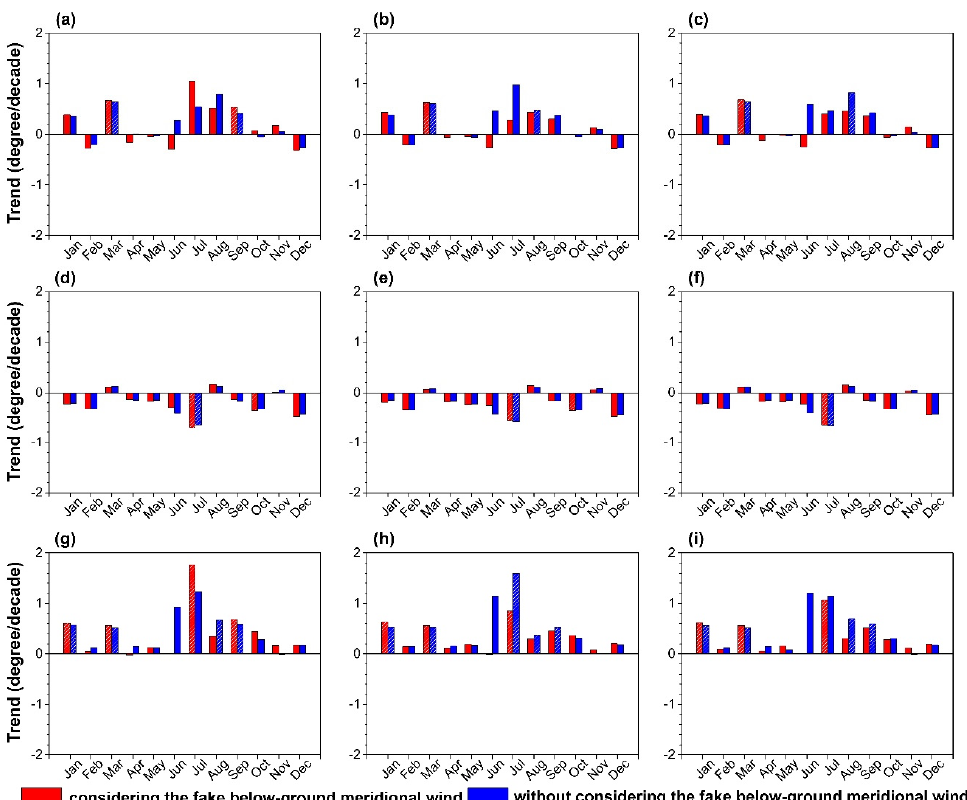
Figure 14. ( a – c ) Annual cycle of the linear trends of the NH HCW from 1979–2018 derived from ( a ) M1, ( b ) M2, and ( c ) M3 using the MRM data sets. The trends that passed the 95% statistical confidence level are filled with oblique lines. The red and blue bars are for the results that considered and did not consider FBGMW, respectively. ( d – f ) and ( g – i ) same as ( a – c ) but for the SH and TOT HCW, respectively. The units for the trends are degrees/decade.